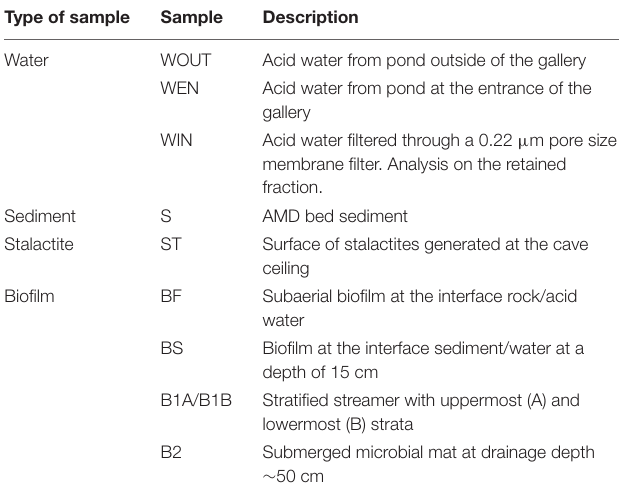
TABLE 1 | List of samples analyzed in this study.